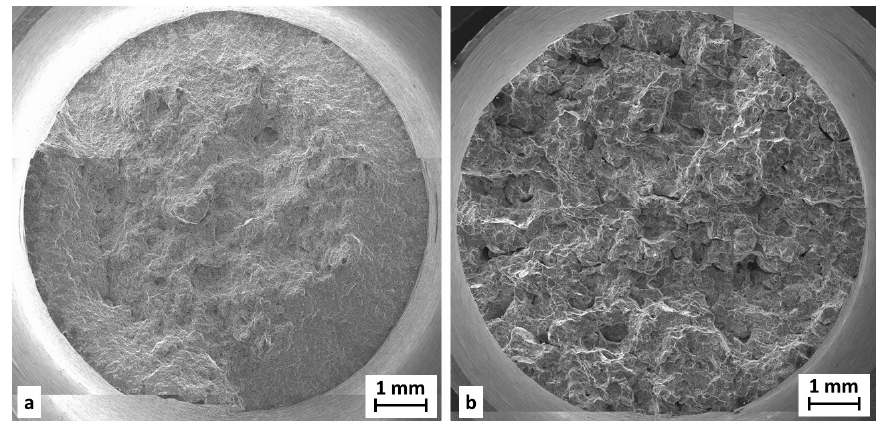
Figure 17. Fraction area of tensile testing samples; ( a ) extruded state material; ( b ) SLM state material fabricated with meander strategy.